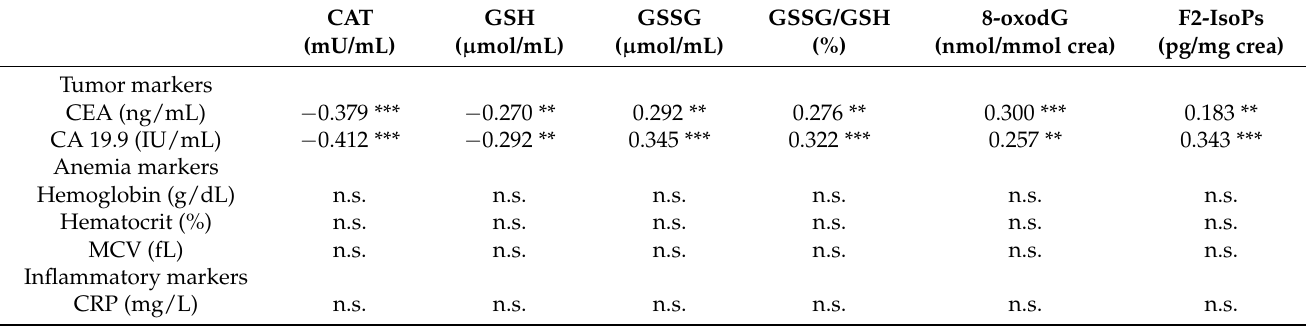
Table 3. Correlation between oxidative stress and tumor and inflammatory markers in controls and CRC